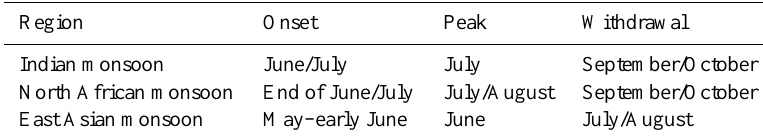
Table 5. Month of onset, peak and withdrawal in the different monsoon regions. Region Onset